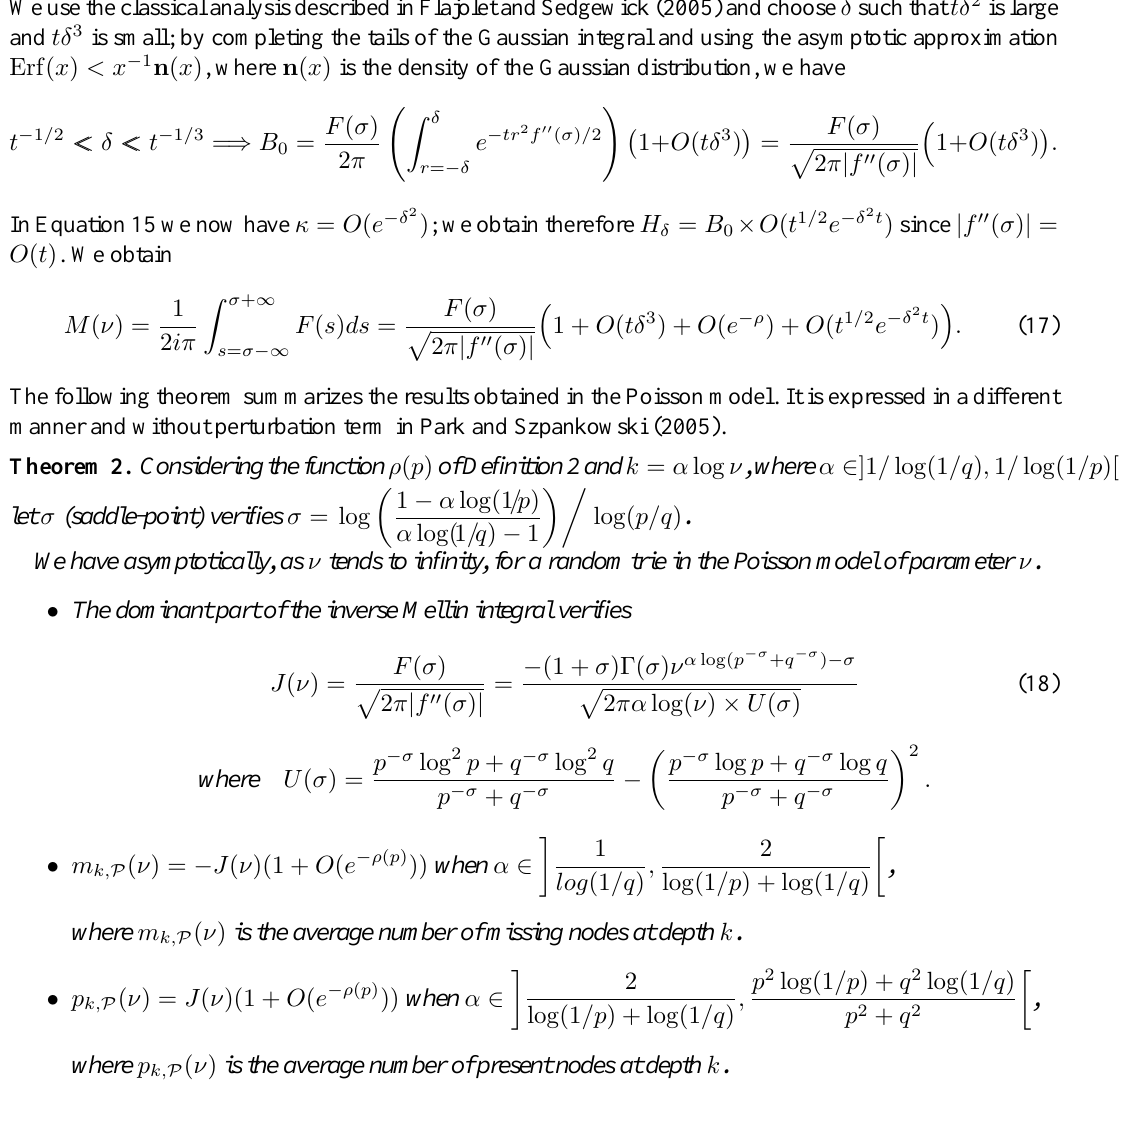
Fig. 5: Saddle-point σ , exponent ζ and η of ν respec- tively in I ( ν ) and I ( ν ) / 2 k (see Equation 18) as a func- tion of β (defined as in Figure 2). We have here p = 0 . 9